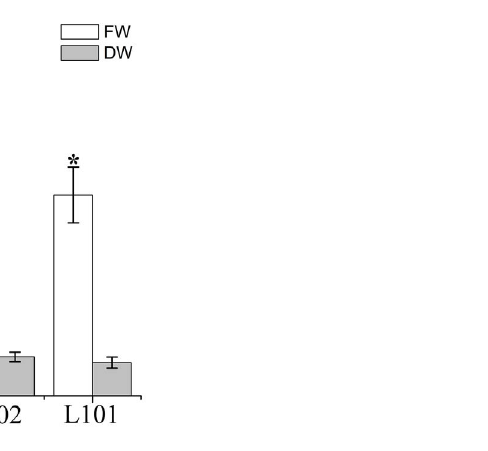
Fig. 8. Biomass of the IbMas -overexpressing sweetpotato plants grown in pots under 200 mM NaCl stress. The 25-cm-long cuttings of the salt-tolerant transgenic plants (L52, L99, L102 and L101) and WTwere grown in 19-cm diameter pots containing a mixture of soil, vermiculite and humus (1:1:1, v/v/v) in a greenhouse, with one cutting per pot, and treated as described in Fig. 6. After treatment, the plant fresh weight (FW) was measured immediately. The plants were then dried for 24 h in an oven at 80 ˚ C and weighed (DW). All treatments were performed in triplicate. Data are presented as means ¡ SE (n 5 3). * and ** indicate a significant difference from that of WT at P , 0.05 and , 0.01, respectively, by Student’s t -test.